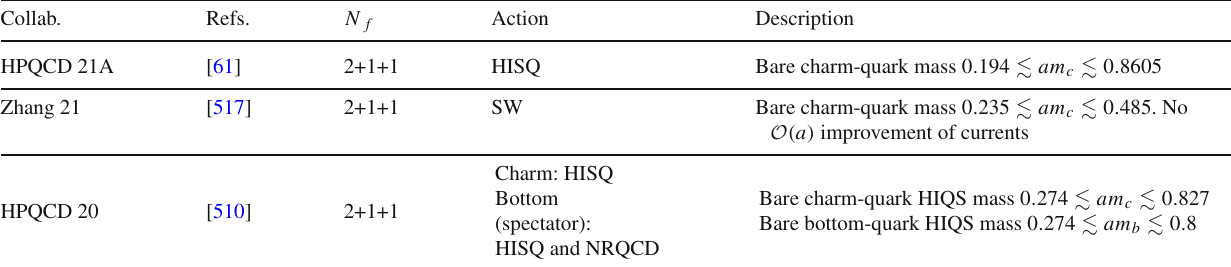
Table 139 Heavy-quark treatment in determinations of form factors for semileptonic decays of charmed hadrons Collab.